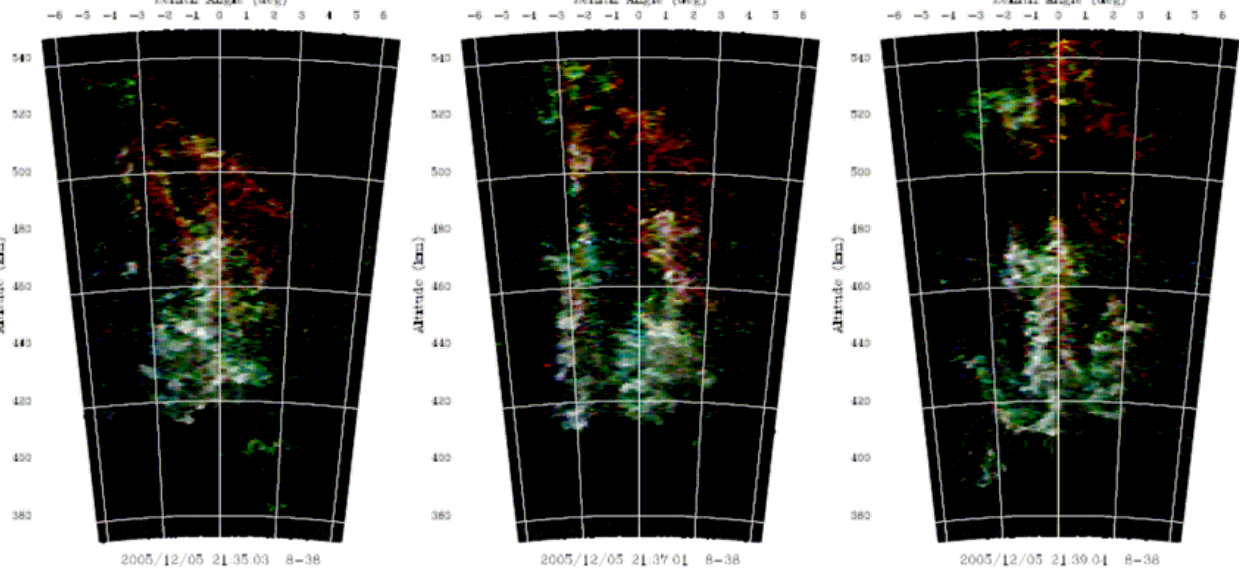
Figure 16. Power and drifts of F and E region backscattering echoes from FAI. Notice the supression of the E region echoes when the velocity of the F region is downwards (after Patra et al., 2004).